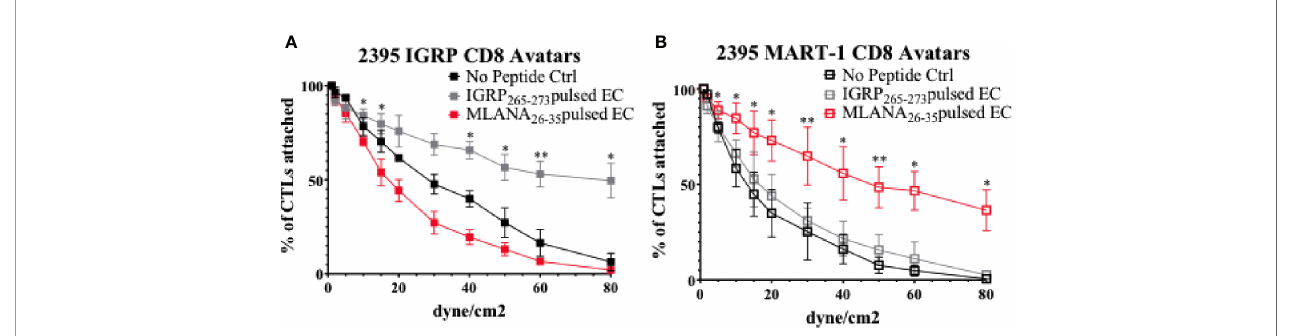
FIGURE 5 | Donor 2395 CD8 + T cell avatars exhibit antigen speci fi c binding to donor 2395 iPS-EC. (A) When donor 2395 IGRP CD8 + T cell avatars are fl owed across a donor 2395 iPSC-derived endothelial cell (iPS-EC) monolayer loaded with IGRP peptide, the IGRP CD8 + T cell avatars adhere more than MART-1 CD8 + T cell avatars or when the iPS-EC is not loaded with peptide. (B) When donor 2395 MART-1 CD8 + T cell avatars are fl owed across a donor 2395 iPSC-derived endothelial cell (iPS-EC) monolayer loaded with Melan-A 26-35 , the MART-1 CD8 + T cell avatars adhere more than IGRP CD8 + T cell avatars or when the iPS-EC is not loaded with peptide. All in vitro hydrodynamic fl ow assay experiments were repeated 3 times. Signi fi cance shown on the graphs were from post-hoc analysis utilizing the Fisher ’ s LSD test. * indicates that p < 0.05 and ** indicates that p